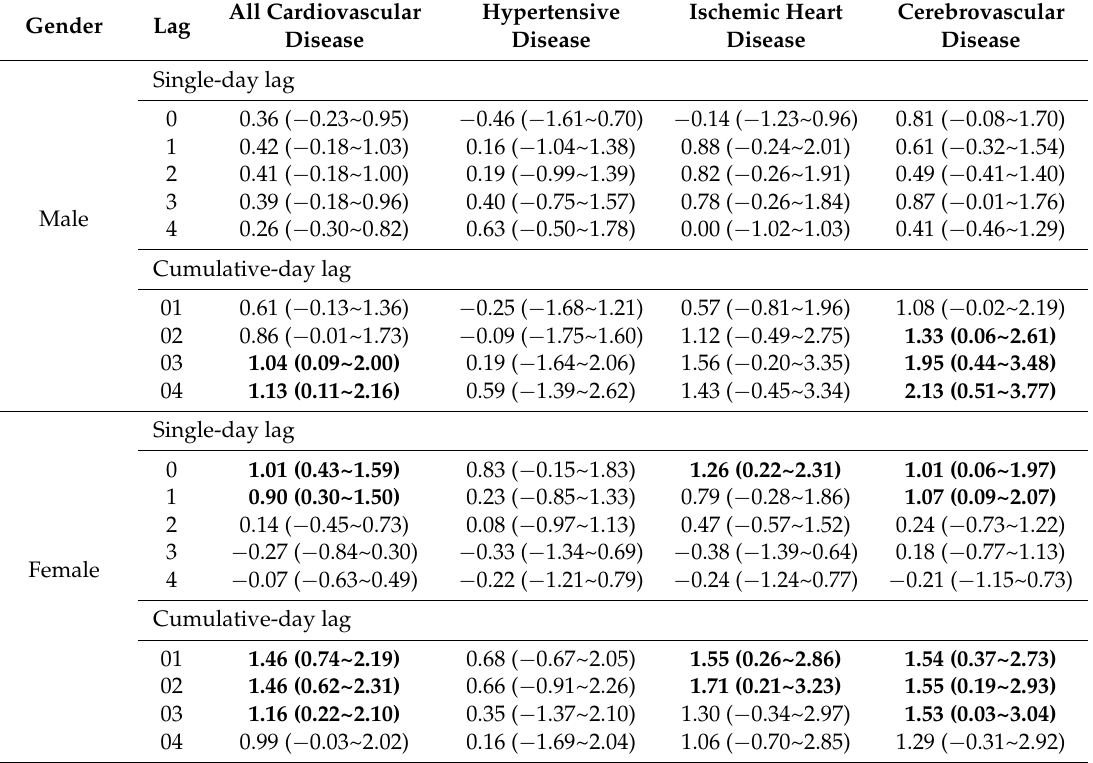
Table 3. Percent change (mean and 95% CI) of the elderly ER admissions associated with a 1 ˝ C variation in DTR by gender in Beijing during 2009–2011 a